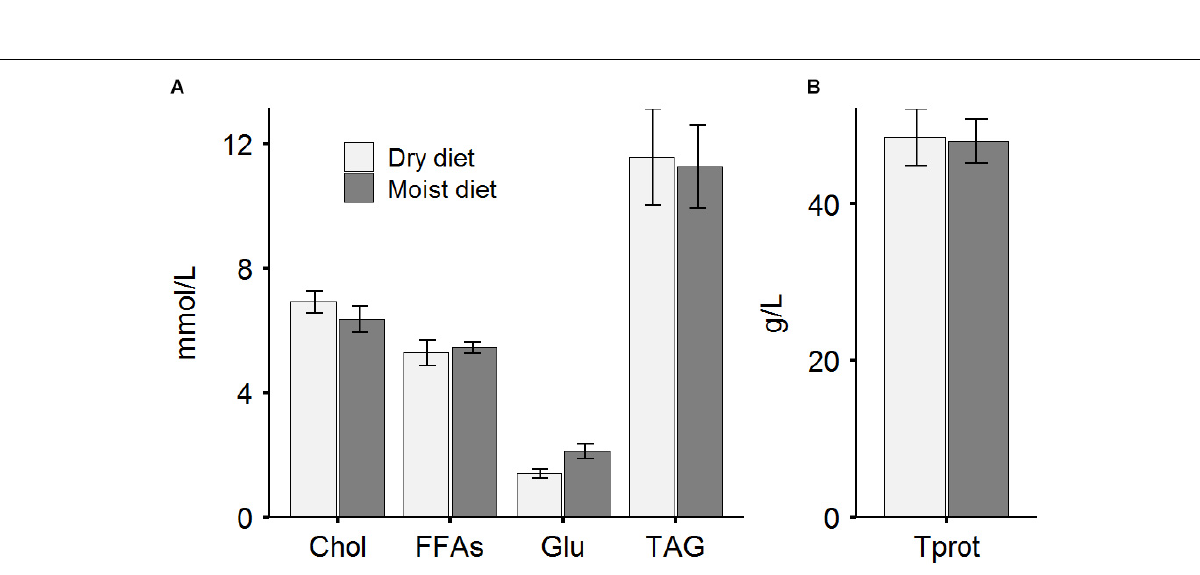
FIGURE 9 | Plasma concentrations of metabolites. (A) The levels of cholesterol, Chol; free fatty acids, FFAs; glucose, Glu; total triacylglycerides, TAG; and (B) total protein, Tprot in plasma collected from ballan wrasse fed dry or moist diets. Data are mean ± SEM ( n = 9 or 12 for dry or moist diets,